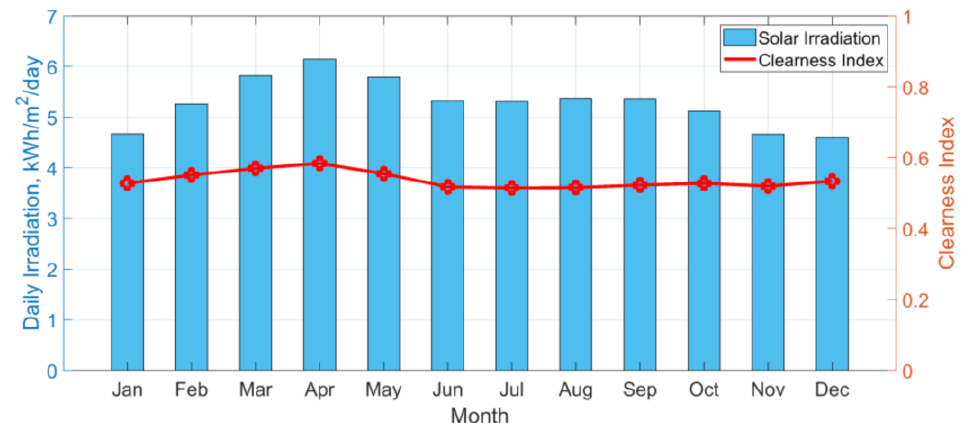
Figure 4. Monthly averages of the solar irradiation per day and the clearness index on Gilutongan Island for the year 2007. Downloaded through HOMER Pro from the National Solar Radiation Database (NSRDB) of the National Renewable Energy Laboratory (NREL) [37].